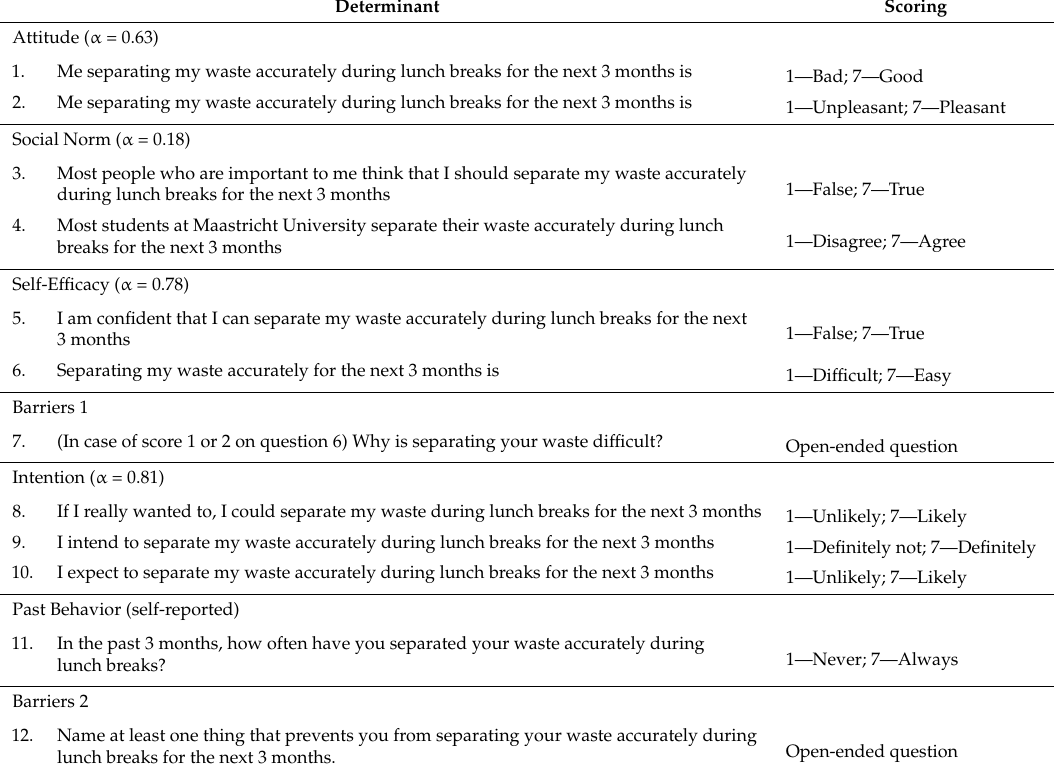
Table 1. Questionnaire to measure social cognitive determinants including intention, barriers, and past behavior. Determinant